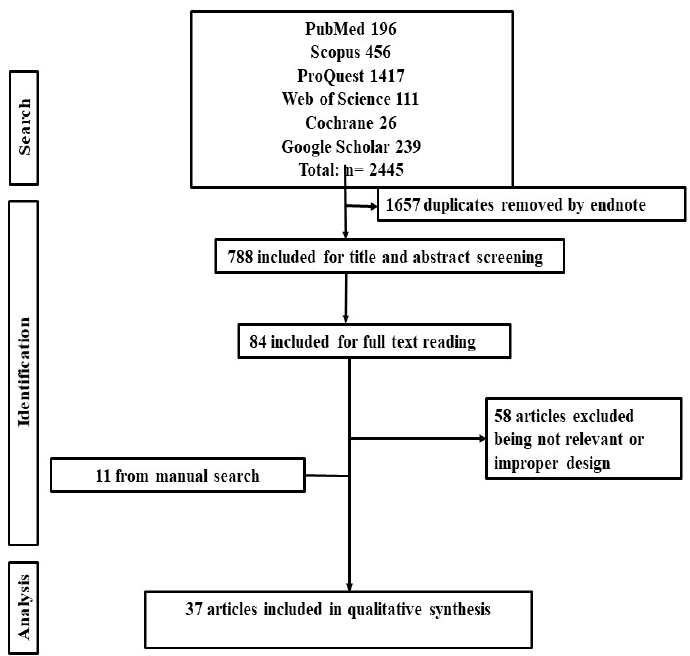
Figure 1. PRISMA flow diagram showing the search strategy of the current systematic review.